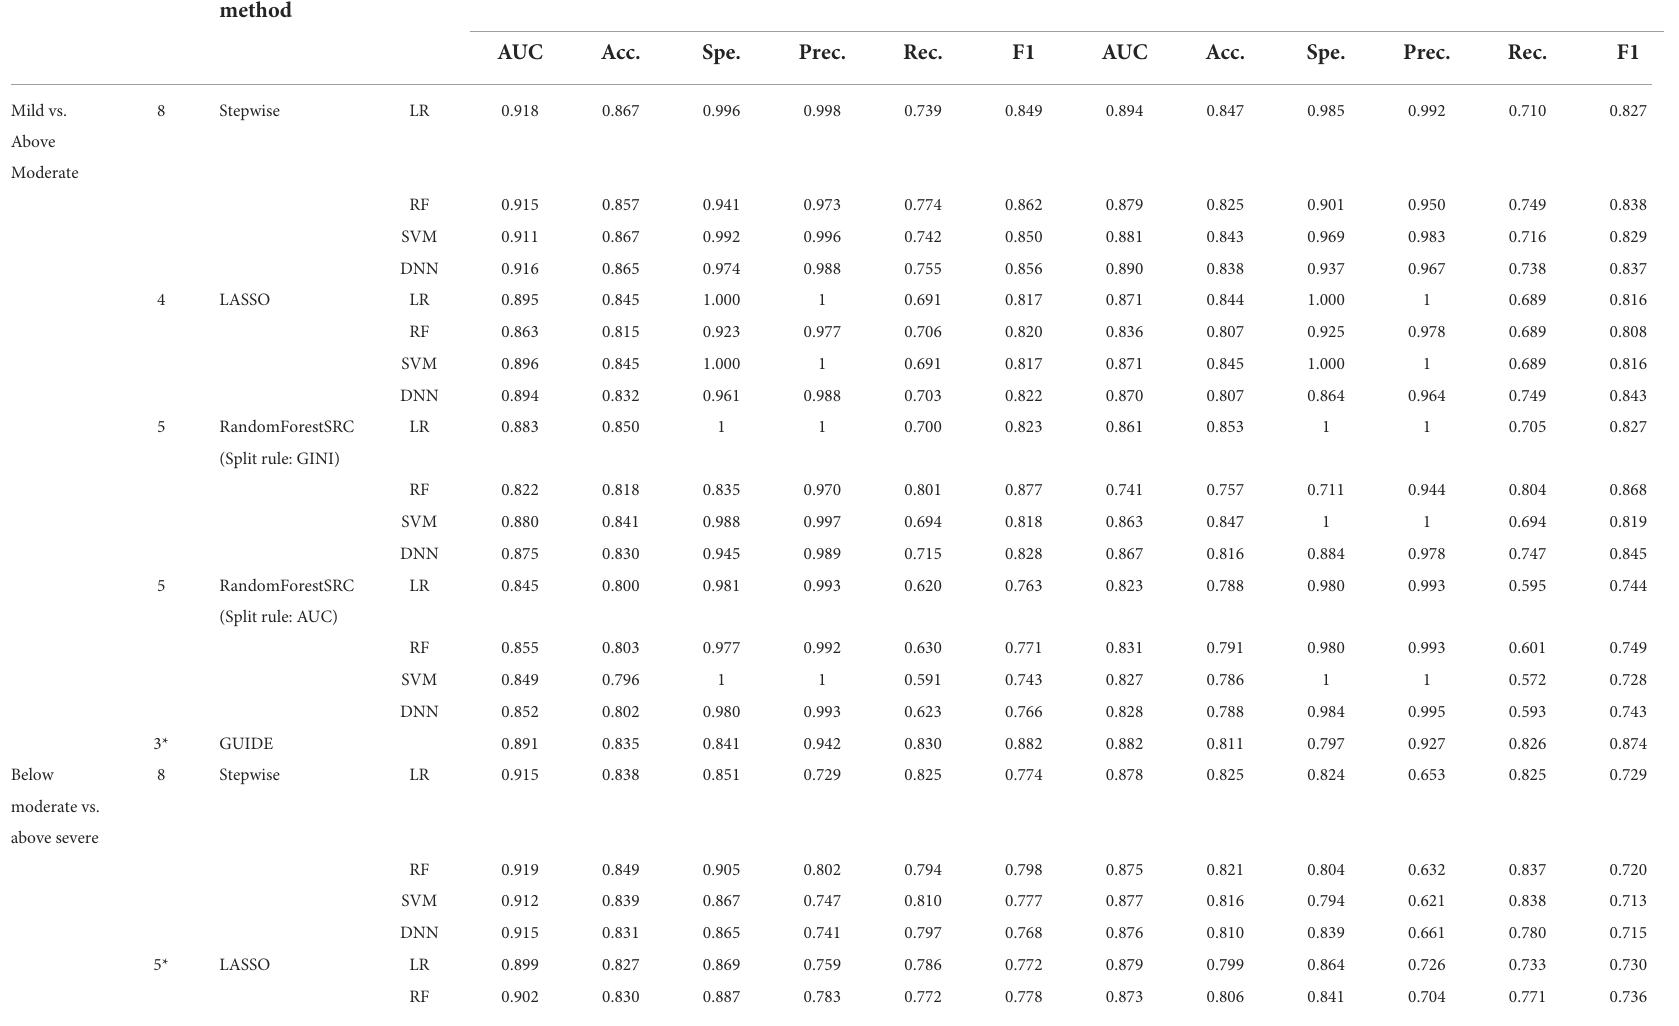
TABLE 4 Predictive models and performance for each binary outcome. Binary